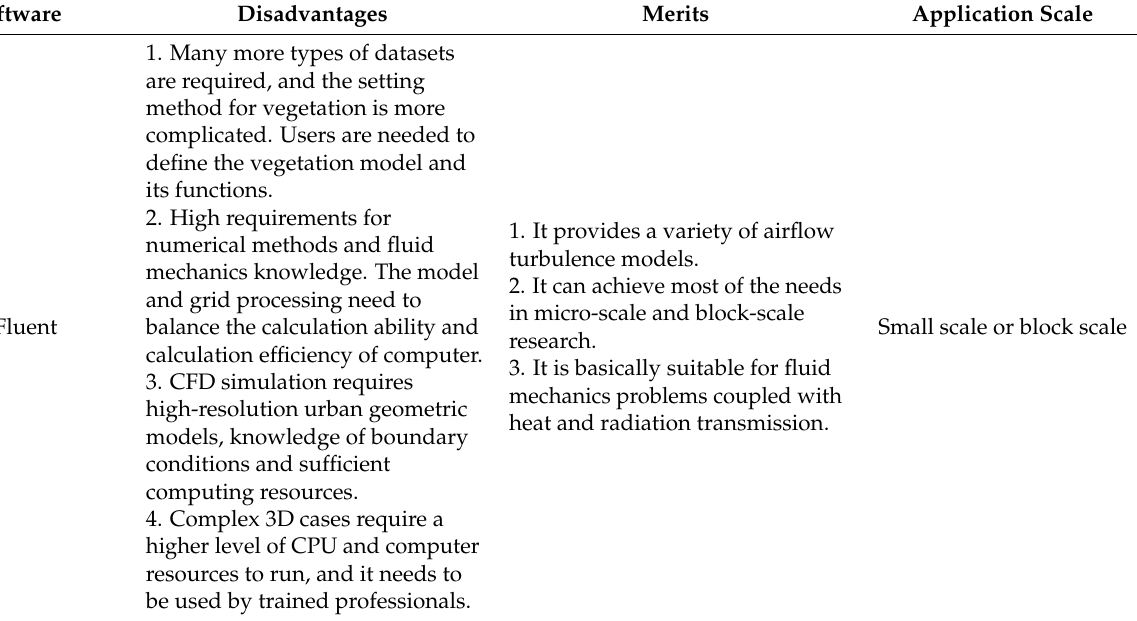
Table 1. The characteristics of ANSYS fluent and Envi-met for simulation of USTE and their merits and disadvantages. Main Software Disadvantages Merits Application Scale